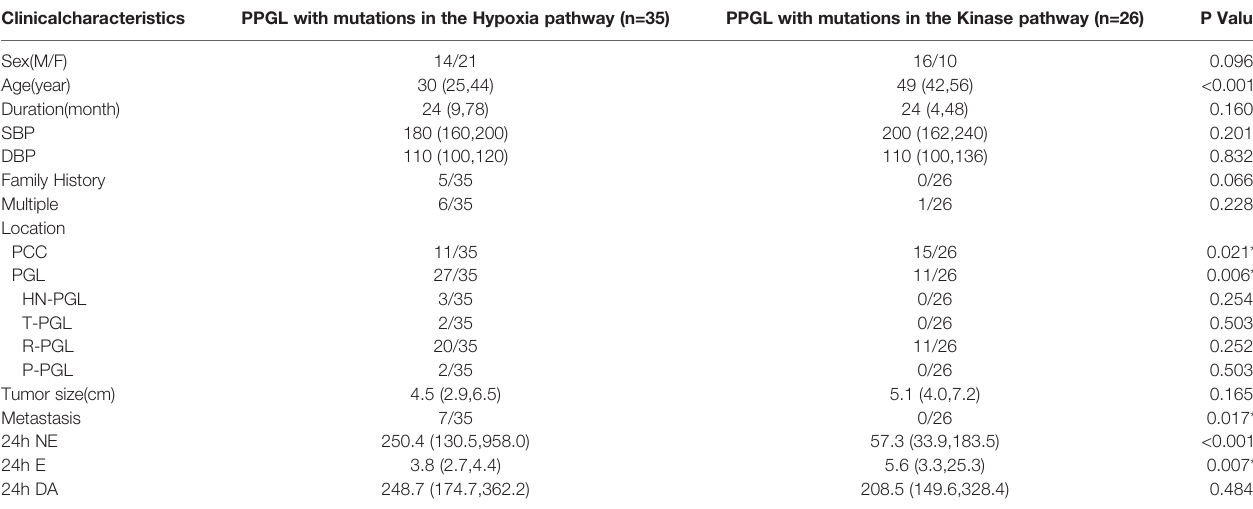
TABLE 3 | Comprison of clinical characteristics of PPGL in different pathways.